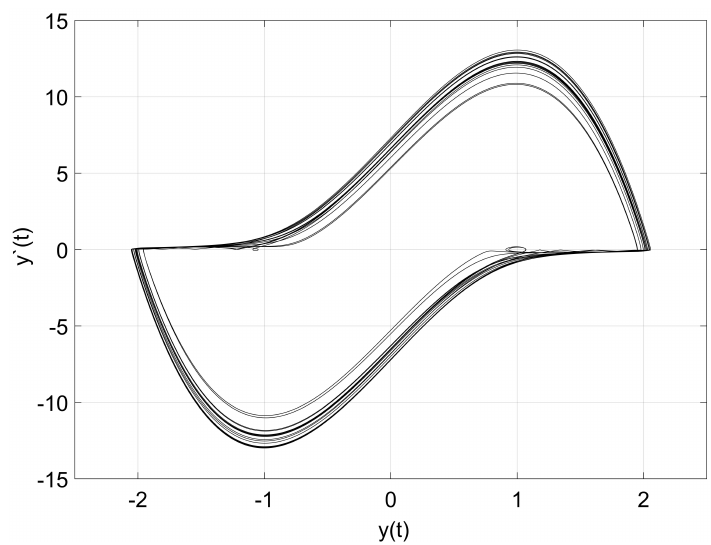
Figure 17. Phase diagram obtained with